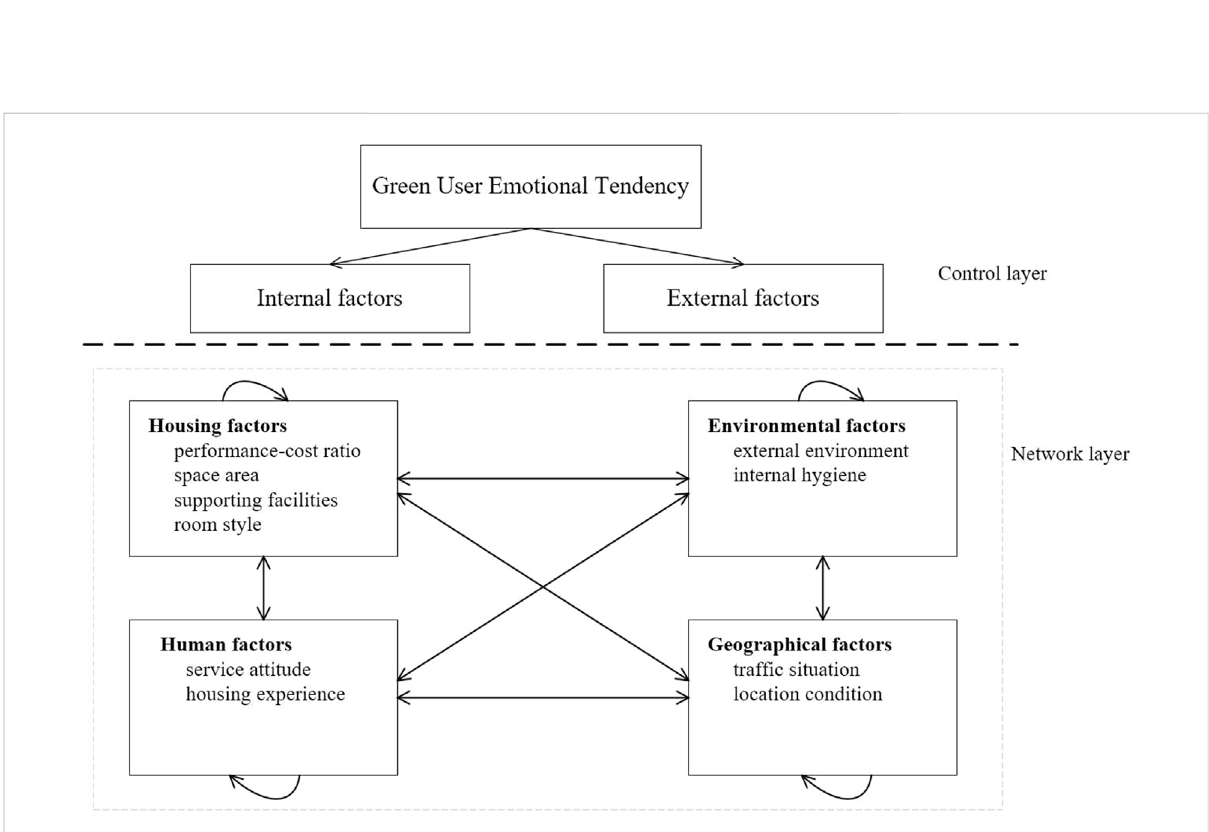
FIGURE 5 Analytic network process model of